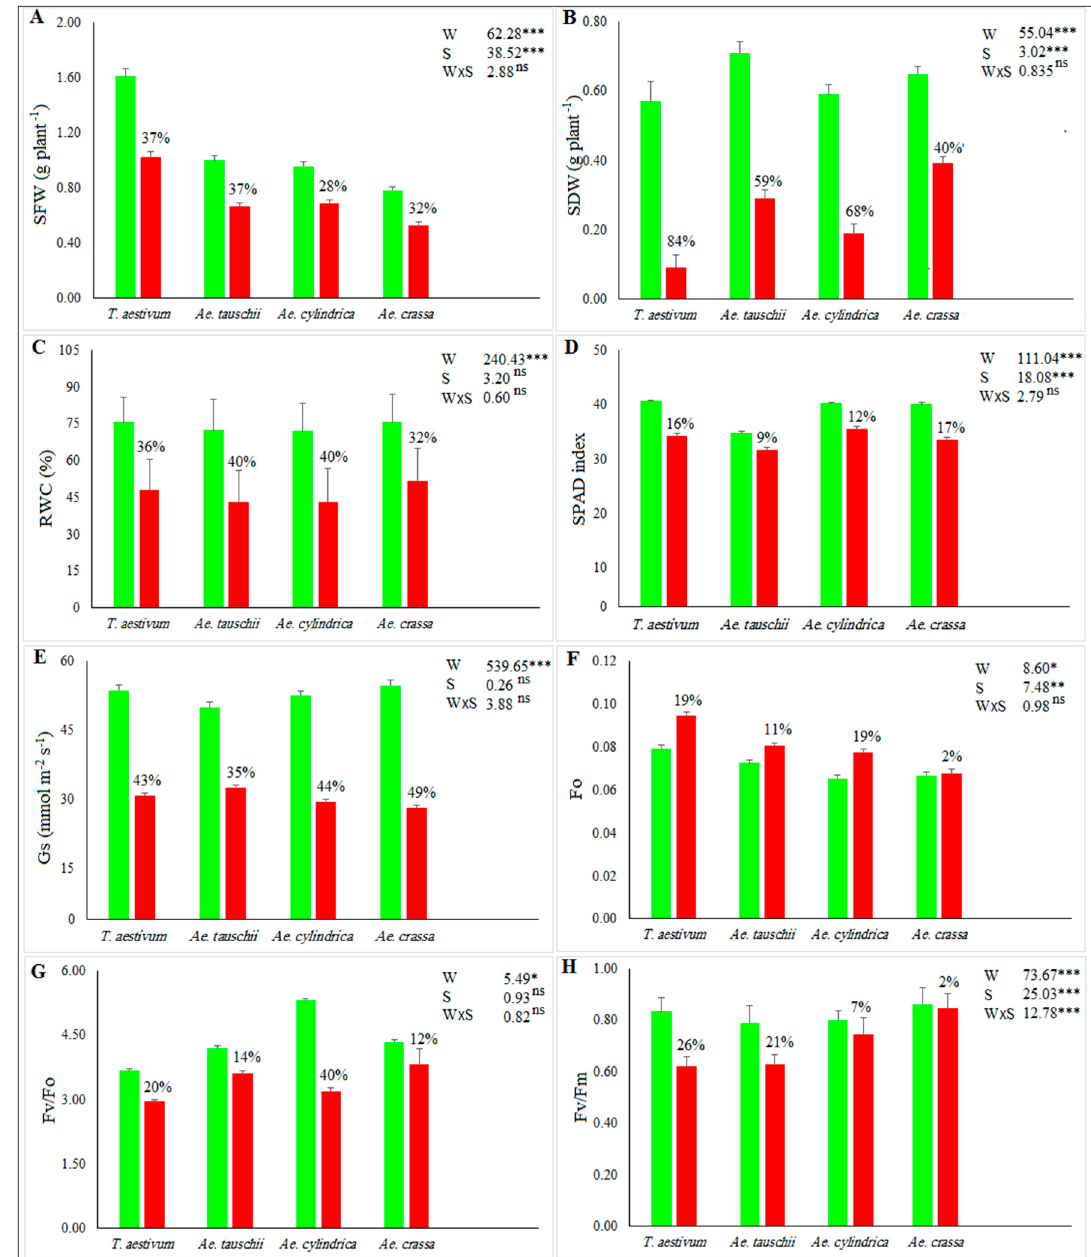
Figure 1. Effect of water deficit stress on measured traits: ( A ) shoot fresh weight (SFW) per plant; ( B ) shoot dry weight (SDW) per plant; ( C ) relative water content (RWC); ( D ) relative chlorophyll content (SPAD); ( E ) stomatal conductance ( Gs ); ( F ) initial fluorescence ( Fo ); ( G ) maximum primary yield of photochemistry ( Fv / Fo ); ( H ) maximum quantum efficiency ( Fv / Fm ) of four species possessing the D genome. Decline (%) due to water deficit stress compared to the control condition is indicated by red bars. Vertical lines on each bar indicate SE. W and S indicate water deficit stress treatment and species, respectively. Ns, *, ** and *** indicate non-significant and significant at the 0.05, 0.01 and 0.001 probability levels, respectively. W, S, W × S indicate water deficit stress, species and their interaction effects, respectively.